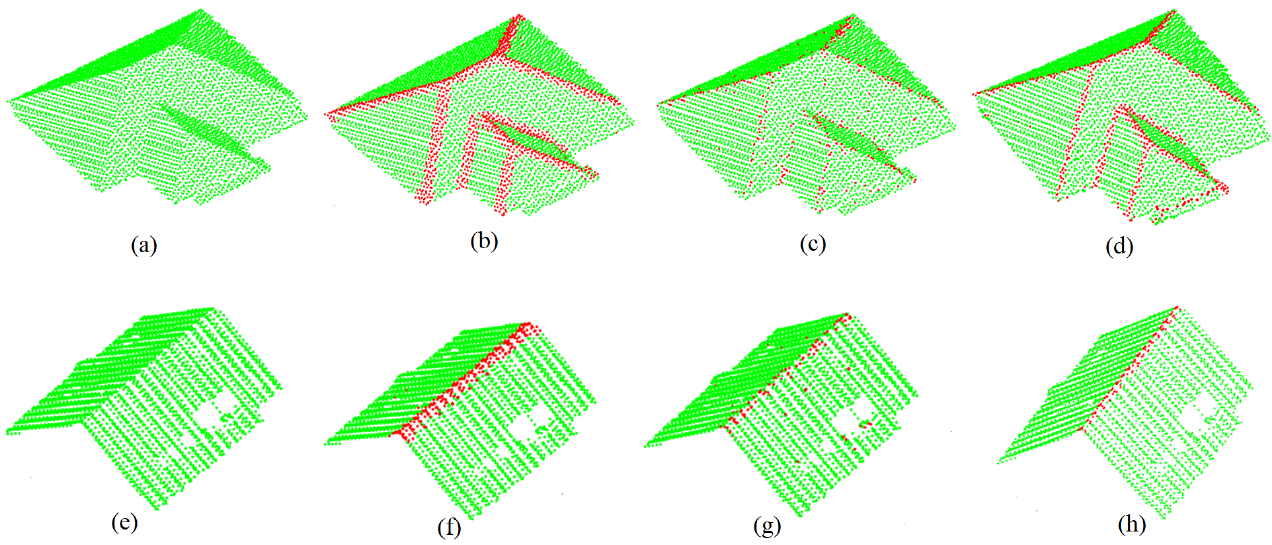
Figure 9. Extracted fold edge points: ( a , e ) original building point cloud, ( b , f ) Analyzing Geometric Properties of Neighbourhood (AGPN) method [16], ( c , g ) Chen method[17], and ( d , h ) Proposed method.